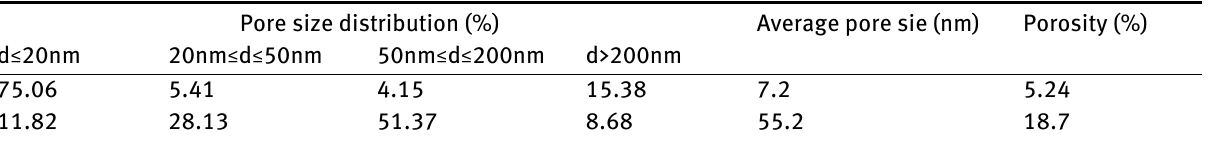
Table 4: Mercury intrusion porosimetry test results